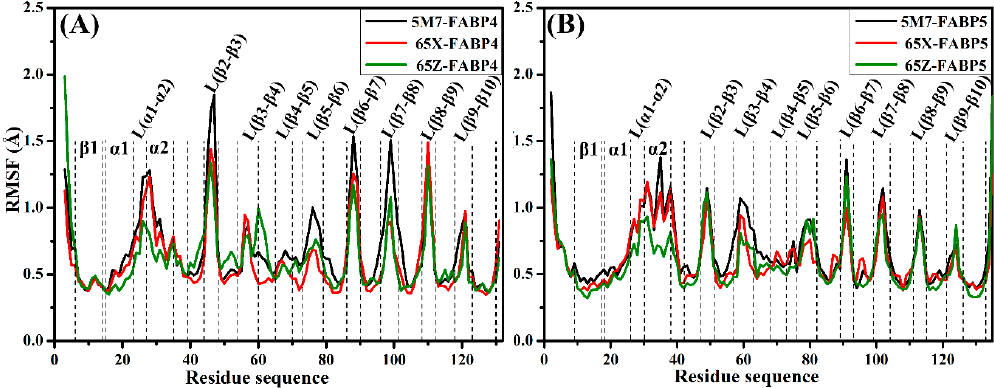
Figure 2. The root-mean-square fluctuations (RMSFs) of C α atoms in FABP4 ( A ) and FABP5 ( B ).